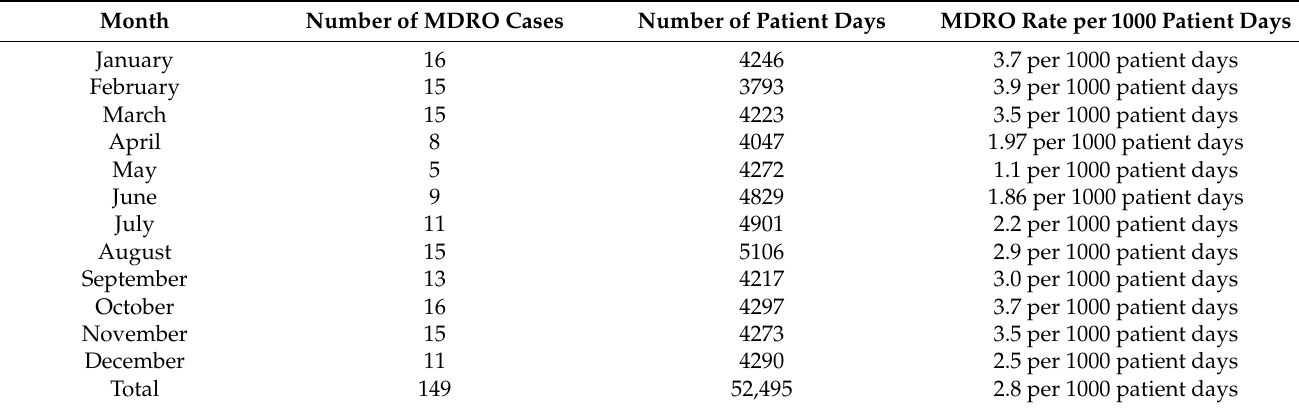
Table 3. HAIs caused by multidrug-resistant